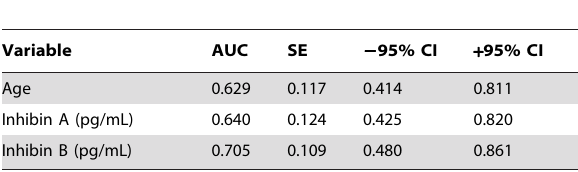
Table 5. The diagnostic value of age and inhibin A and B for the prediction of death within five